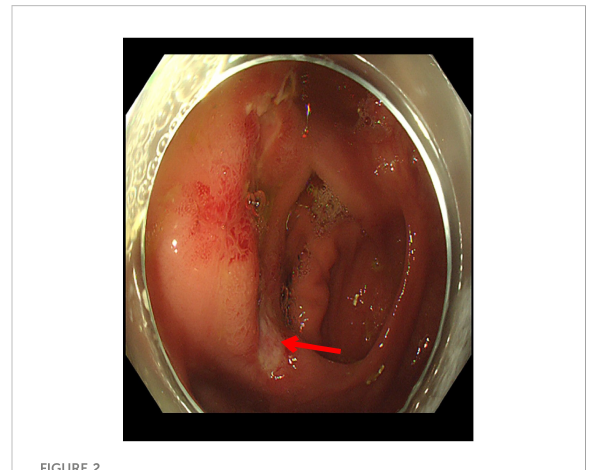
being seen on the ileocecal valve.